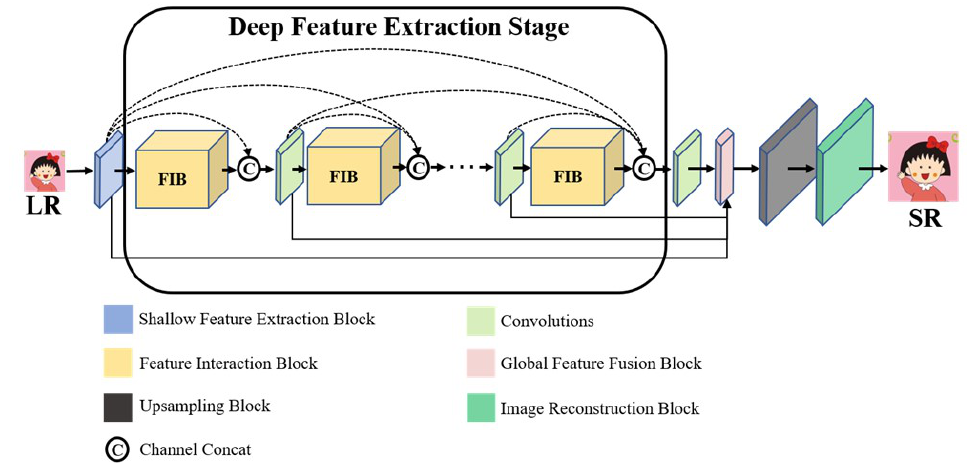
Figure 2. The architecture of our proposed lightweight image reconstruction network